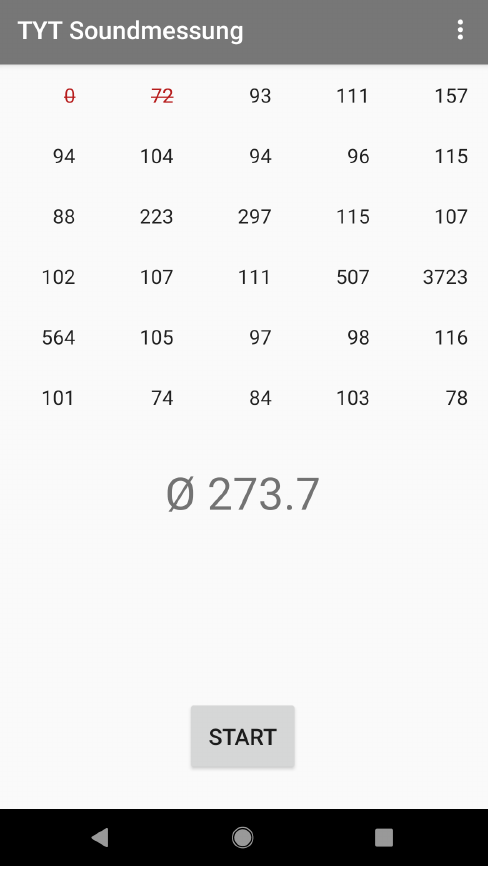
Figure 1. Screenshot of the sound measurement mobile application used for the experiments. The values displayed represent the individual amplitude values for each of the 500 ms periods as well as the average amplitude over the entire 15 s measurement period (the large number in the center of the